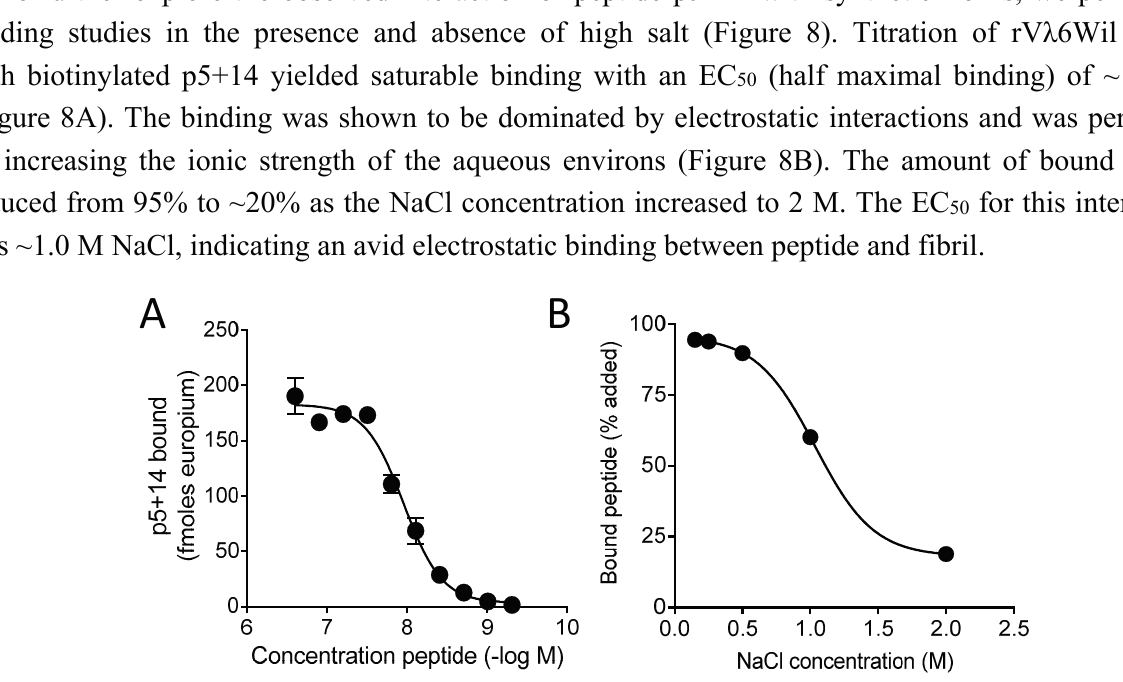
Figure 8. Peptide p5+14 avidly bound synthetic rV λ 6Wil fibrils via electrostatic interactions. ( A ) Titration of biotinylated p5+14 on immobilized rV λ 6Wil fibrils. Each point is